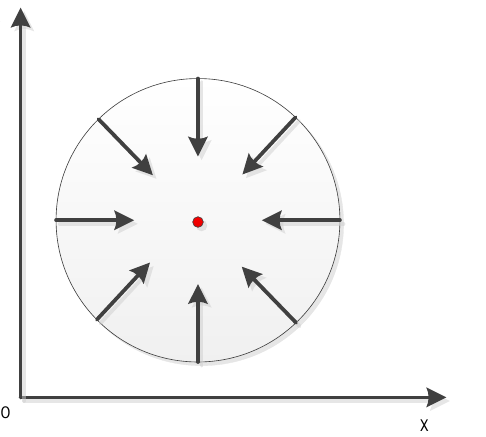
Figure 6. Schematic diagram of the relationship between module vector and circle center.